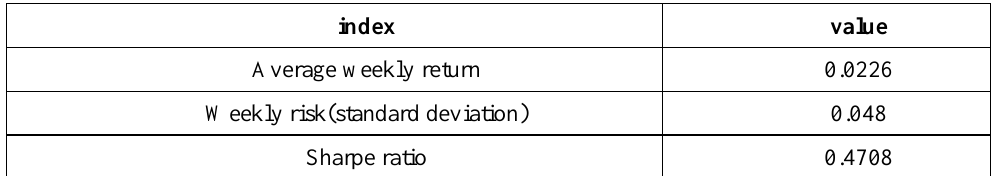
Table 9. Markowitz portfolio performance on test